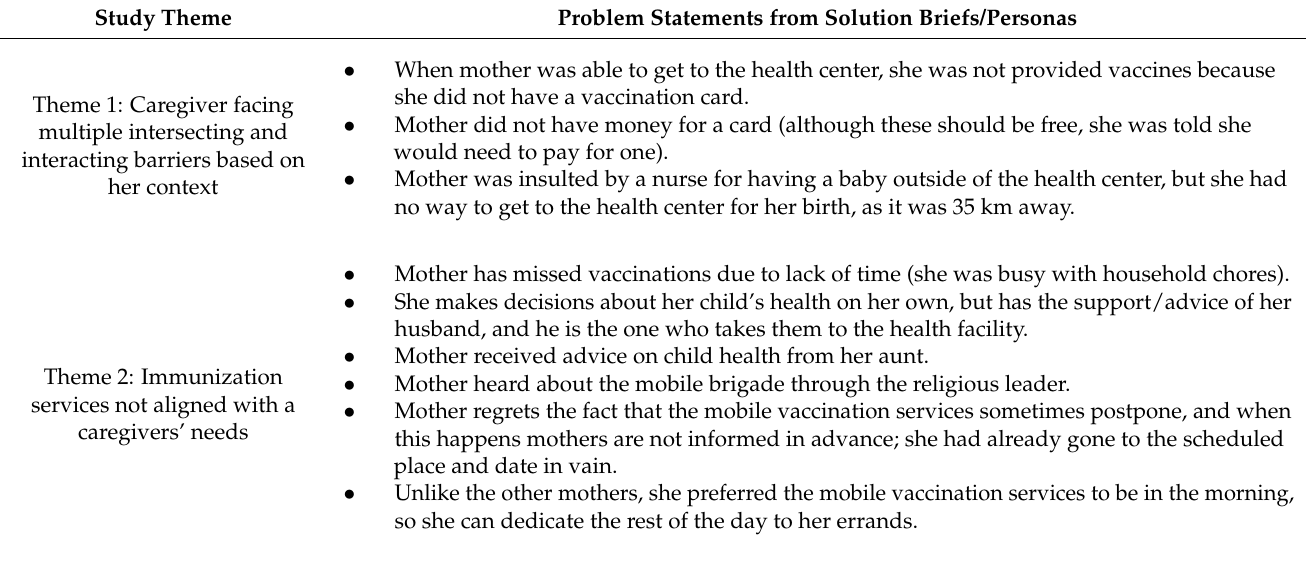
Table 2. Select caregiver personas used during co-creation workshops, based on study